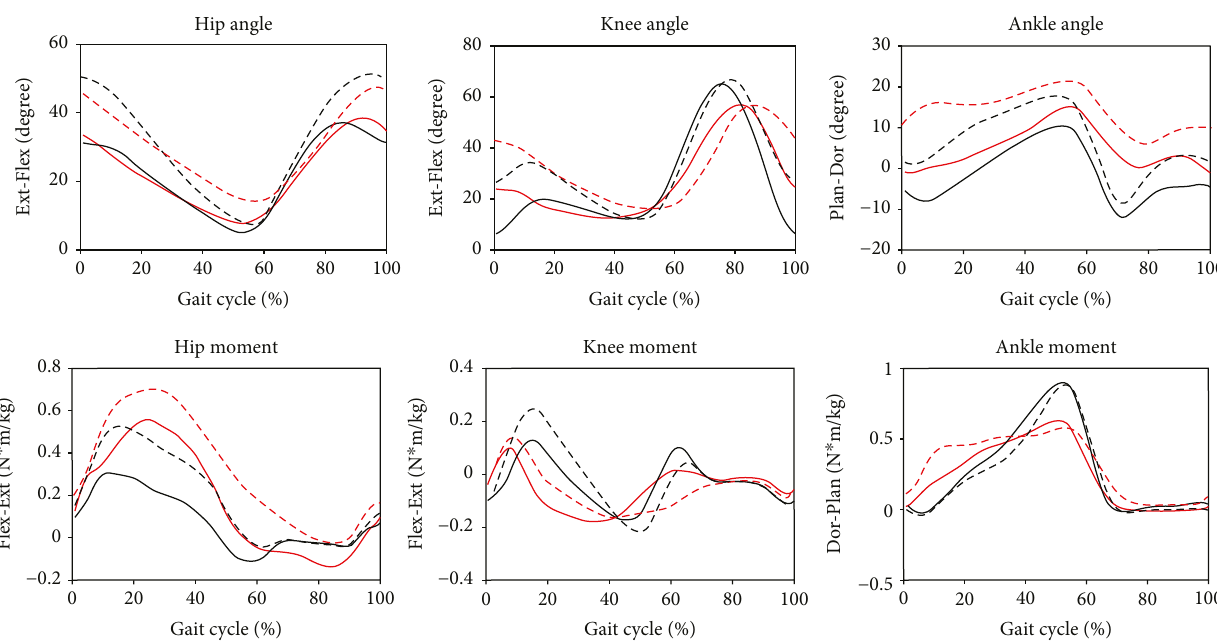
Figure 2: Mean joint angles and joint moments for CP and TD during level ground walking and uphill walking (solid black line: TD level walking; dashed black line: TD uphill walking; solid red line: CP level walking; dashed red line: CP uphill